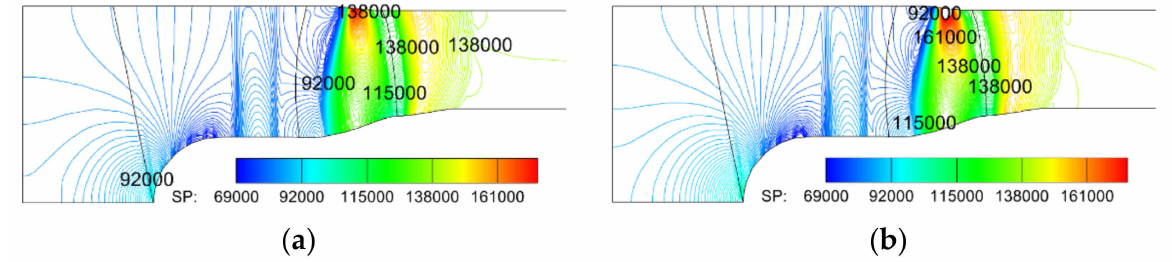
Figure 23. Isoline of the static pressure for 11D: ( a ) distorted; ( b ) clean.